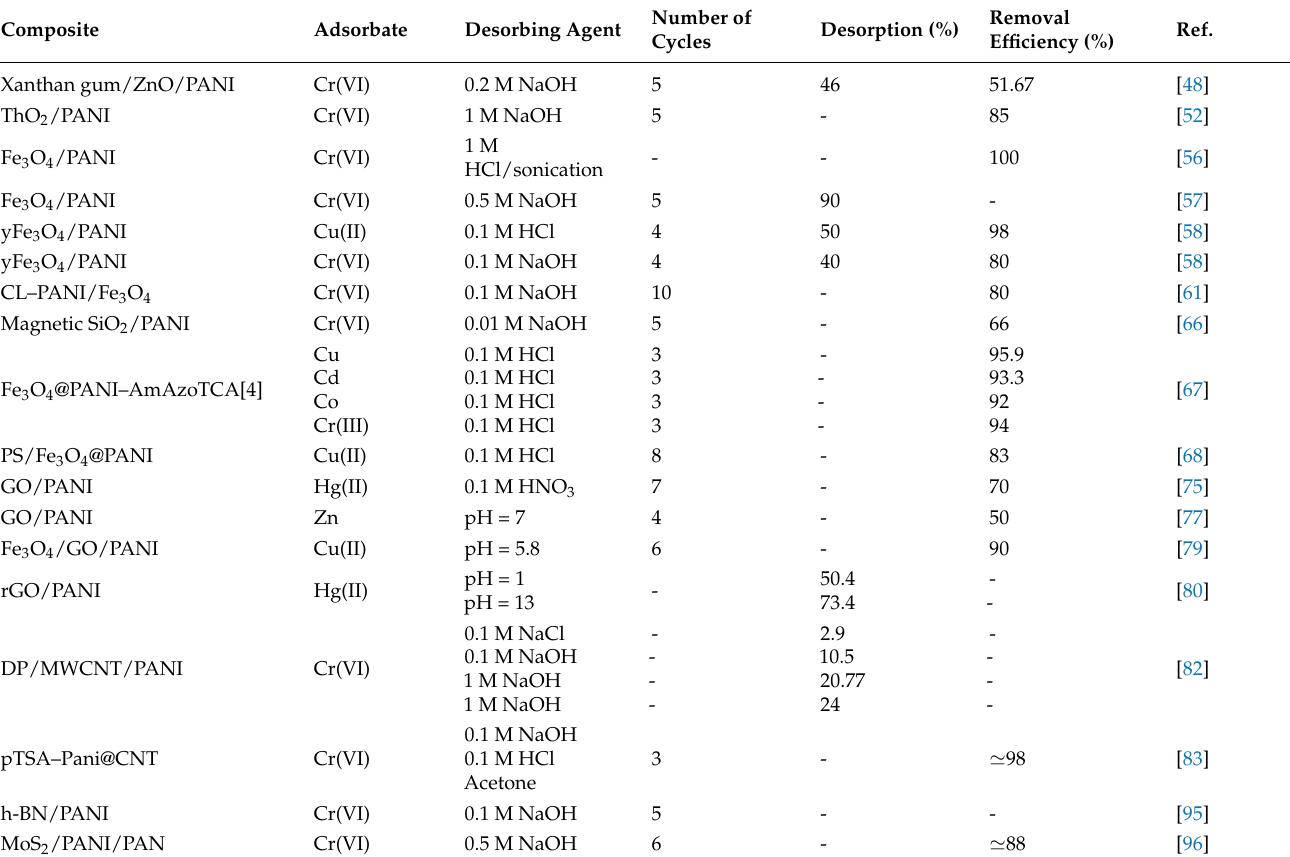
Table 1. Summary of various desorbing agents for the regeneration of PANI nanocomposite adsorbents.